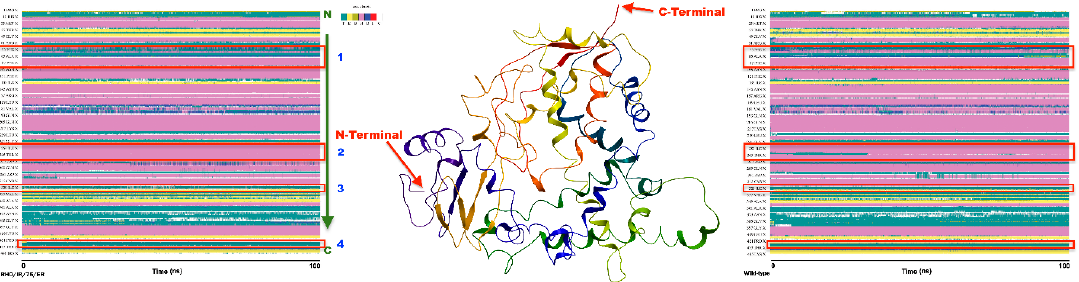
Figure 7. Time-base monitoring of secondary structural elements of CYP51 proteins during the simulation. For clarification, the ribbon representation of the protein with was shown in the middle of the figure. Red boxes are an approximate location of the catalytic pocket residues of the proteins.